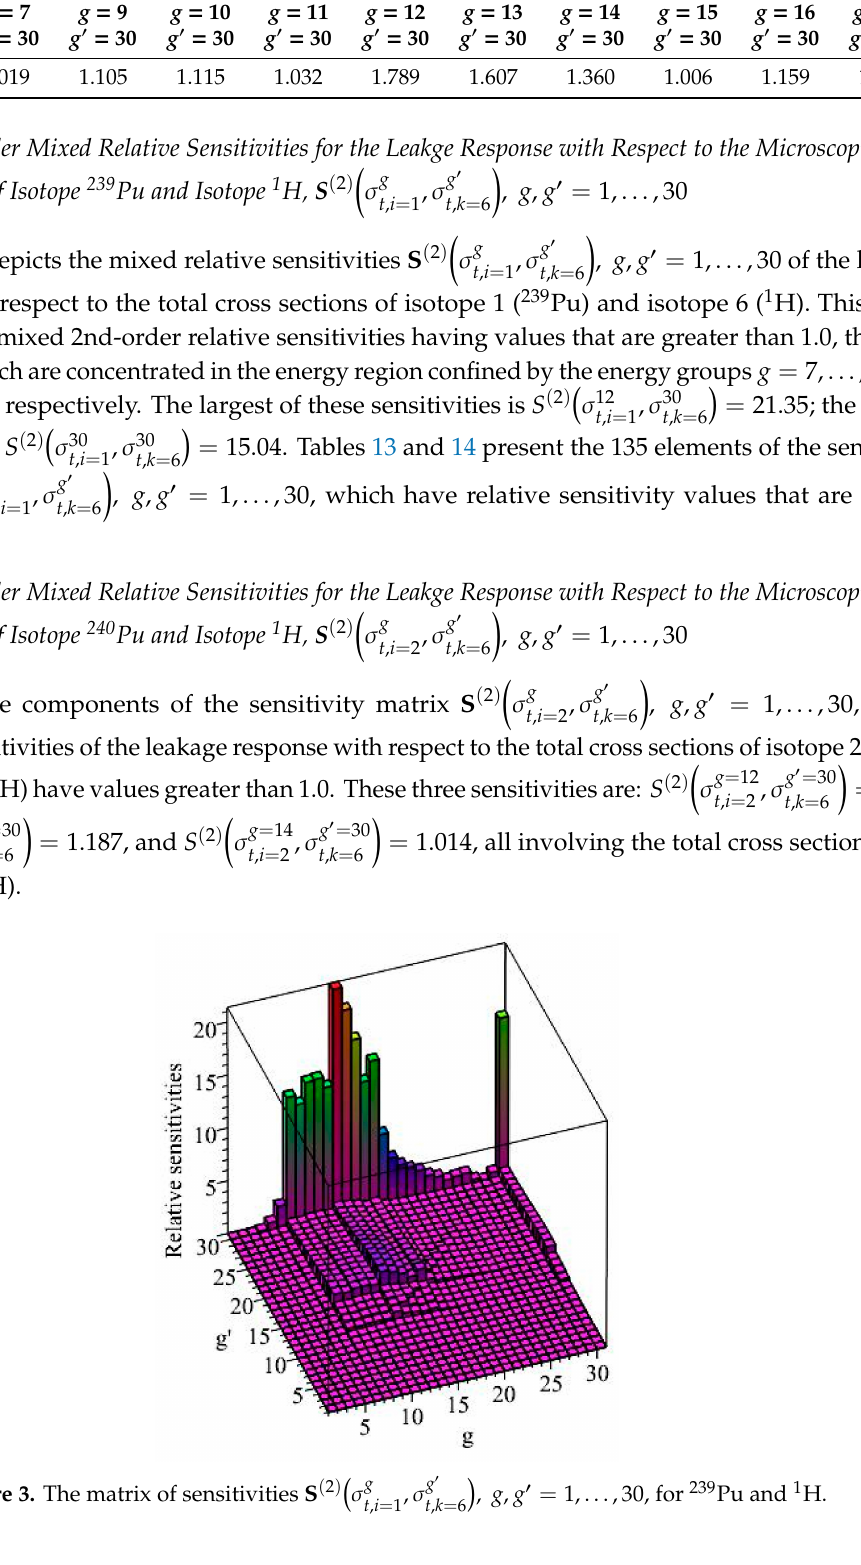
Table 12. Components of S ( 2 )